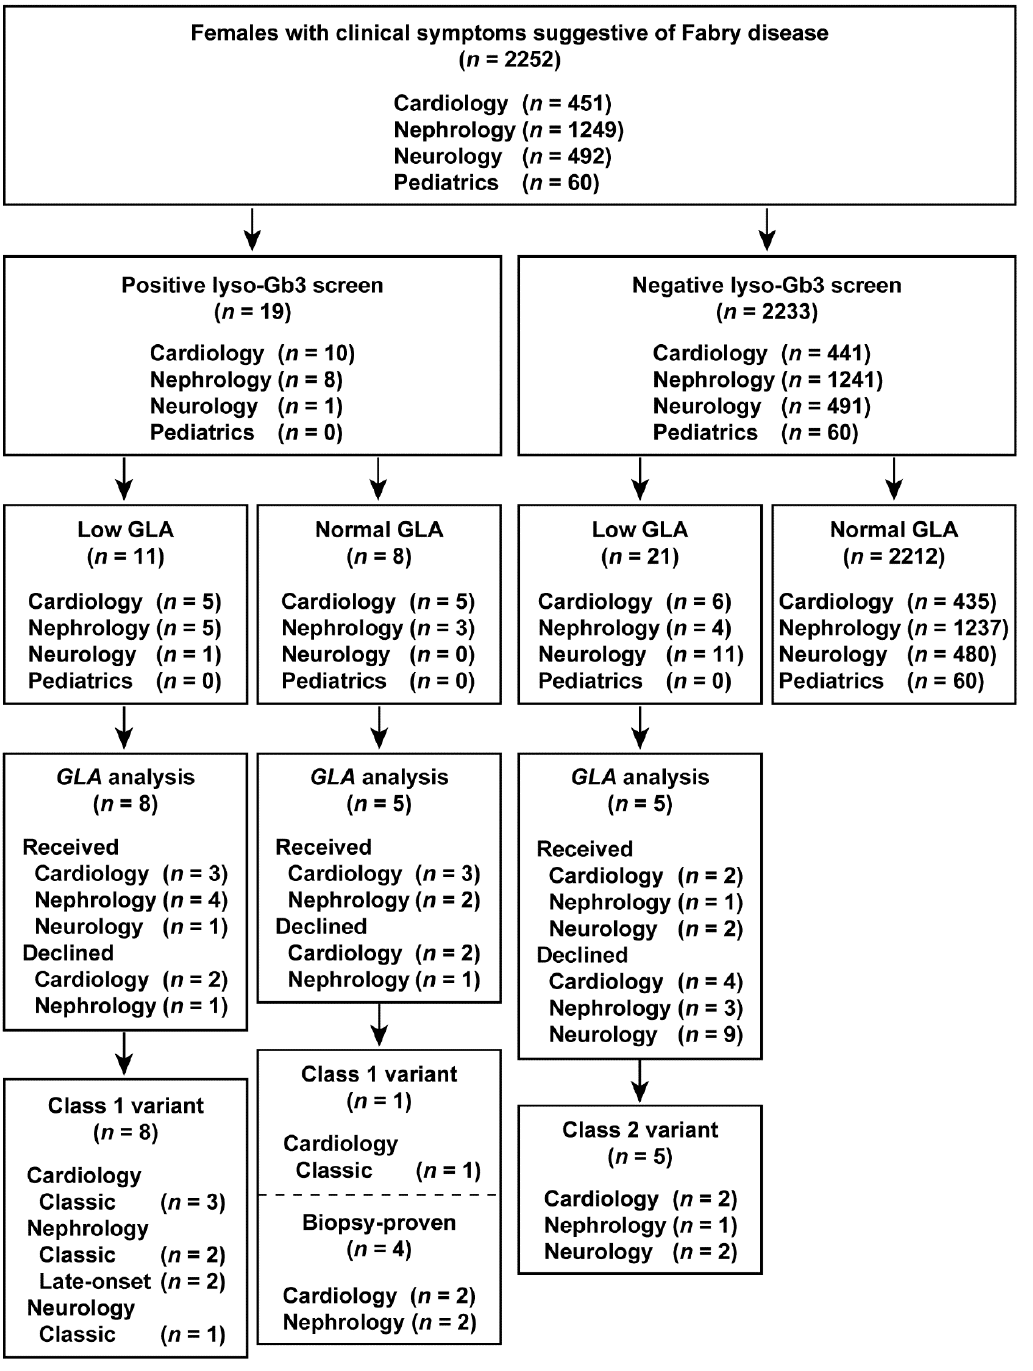
Figure 3. Flowchart of the combination of lyso-Gb3 and GLA activity screening and GLA analysis in female patients. Female patients enrolled between 1 July 2014 and 31 December 2016.